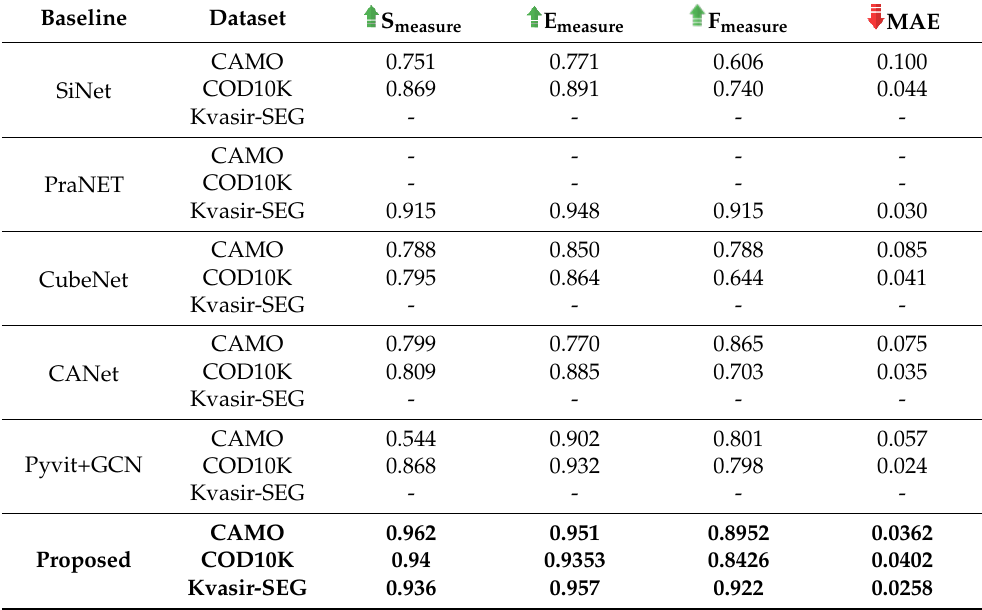
Table 2. Comparison of the proposed OGR w.r.t Baselines Camouflage models and datasets.